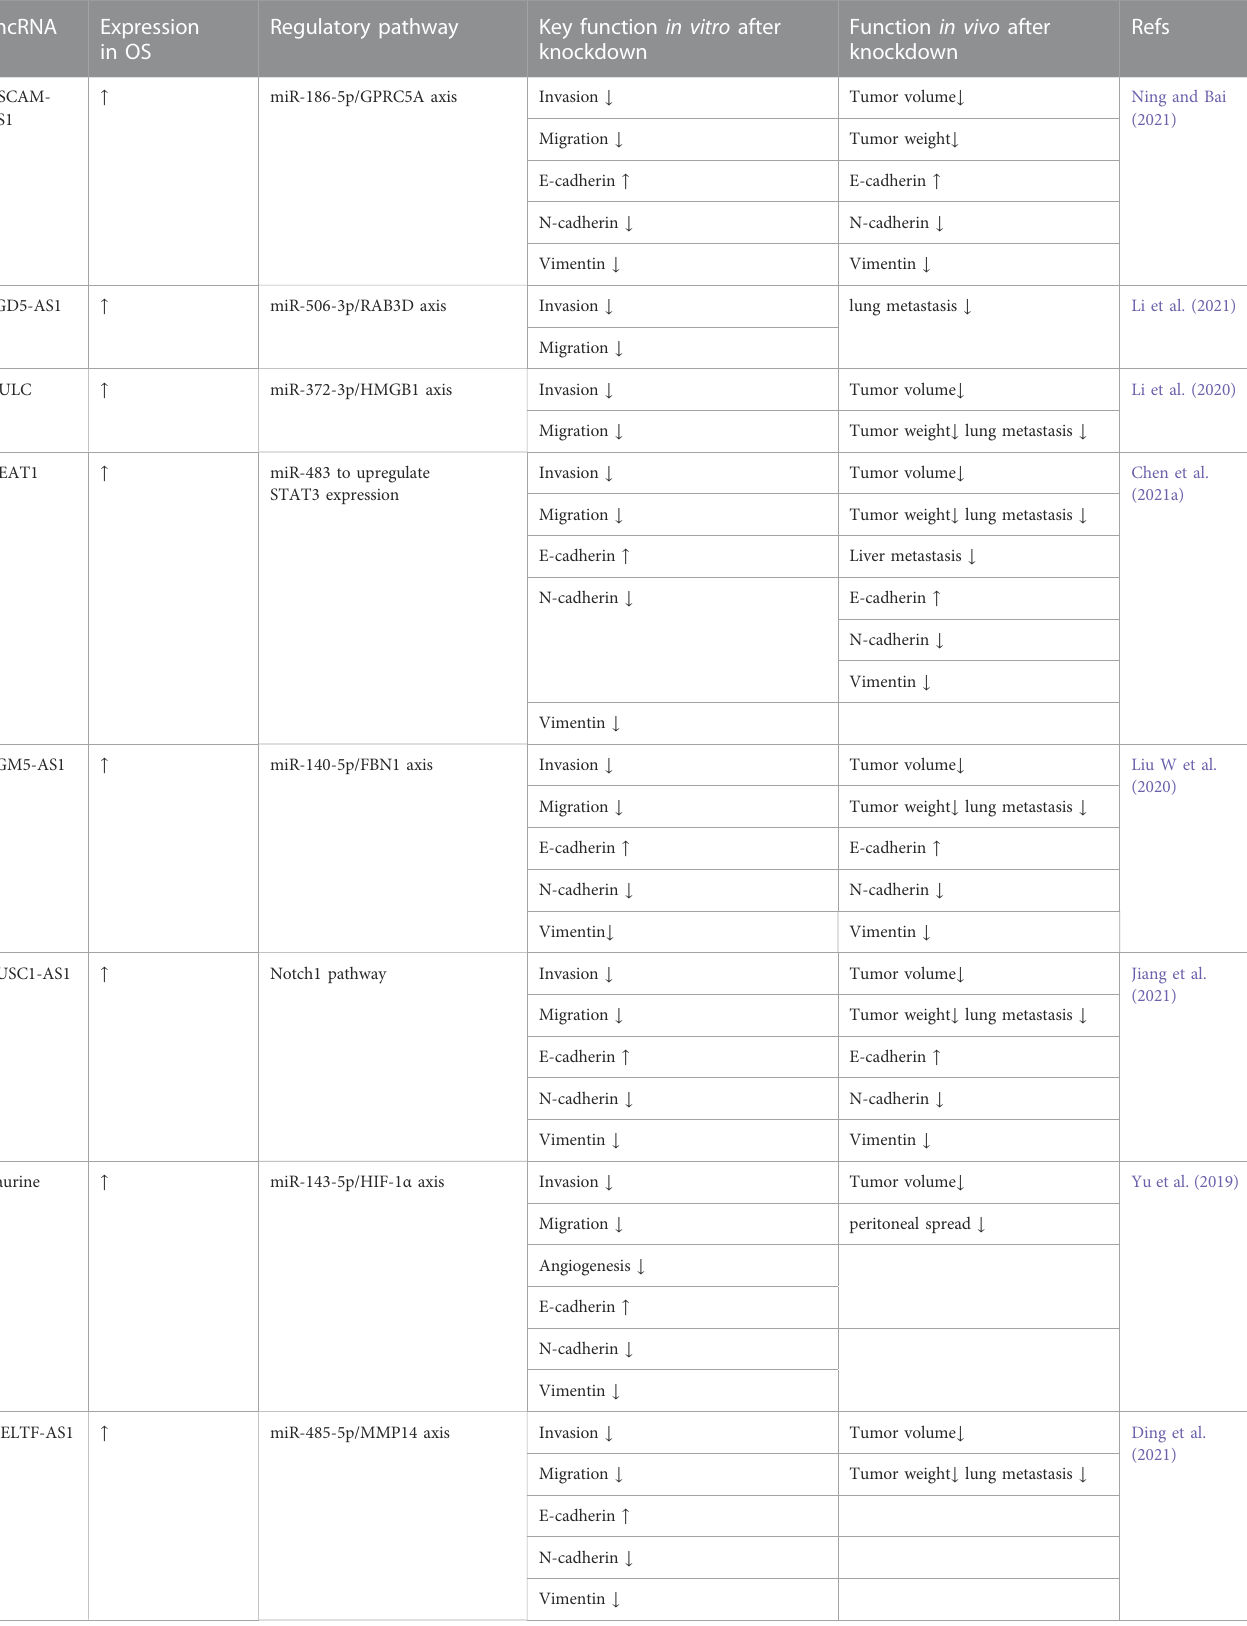
TABLE 6 Oncogenic lncRNAs associated with antitumor effects in vivo